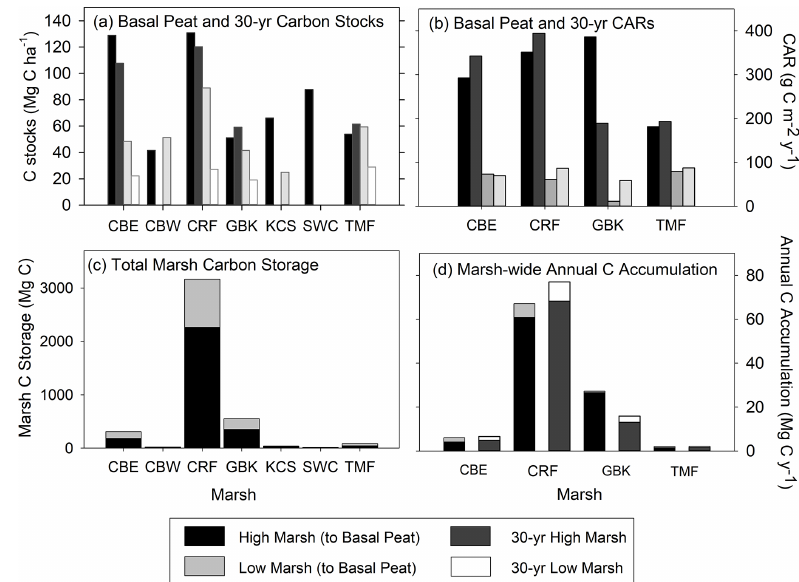
Figure 5. (a) High and low marsh carbon stocks (MgCha − 1 ) measured to the base of peat layer and for the last 30 years; (b) high and low marsh carbon accumulation rates (CARs, gCm − 2 yr − 1 ) measured to the base of peat layer and for the last 30 years; (c) total marsh carbon (MgC) estimate to the base of peat layer for high and low marsh zones of each marsh; and (d) marsh-wide annual C accumulation (MgCyr − 1 ) estimated to the base of peat layer and for the last 30 years. Paired differences between high and low marsh CARs are statistically significant for CARs calculated to the base of peat layer ( t = 4 . 283, p value = 0.0234) and for 30-year CARs ( t = 4 . 043, p value = 0.0272). (Statistical comparisons of C stocks are in Fig.